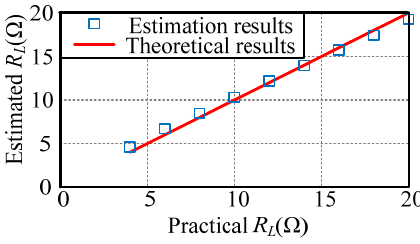
Figure 17. Identification results of the load resistance, R L .